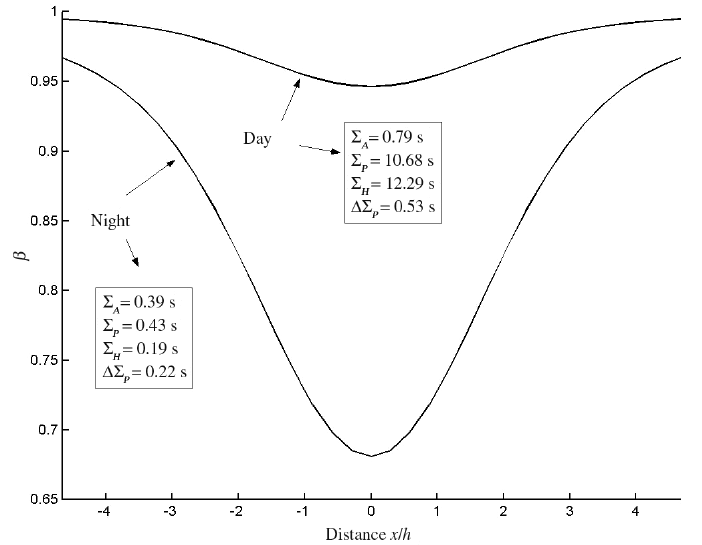
Fig. 3. Spatial distribution of the relative magnetic field β dependence on distance from projection of the per- turbation center in the ionosphere, h is height of lower boundary of the ionosphere (here h = 100